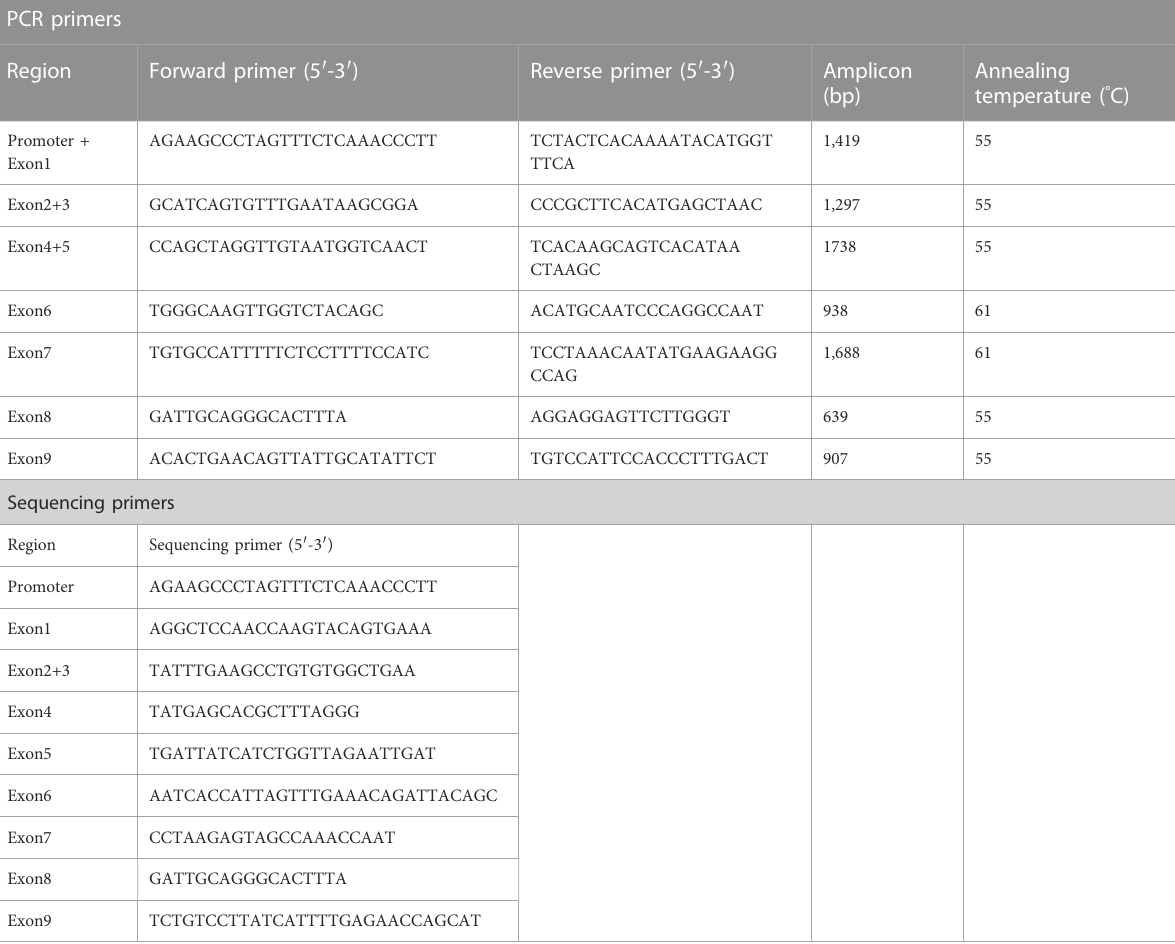
TABLE 1 Optimized primers for ampli fi cation or sequencing of human CYP2C9